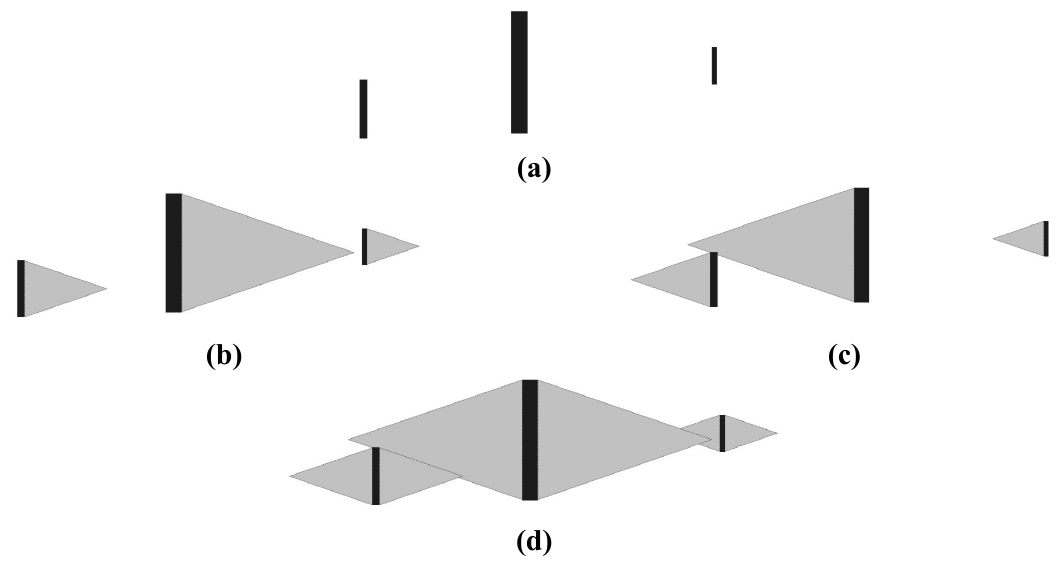
Figure 8. Text line segmentation water flow algorithm involving water flow angle α : (a) initial text containing three I letters. (b) unwetted areas made by water flow from left to right. (c) unwetted areas made by water flow from right to left. (d) united unwetted